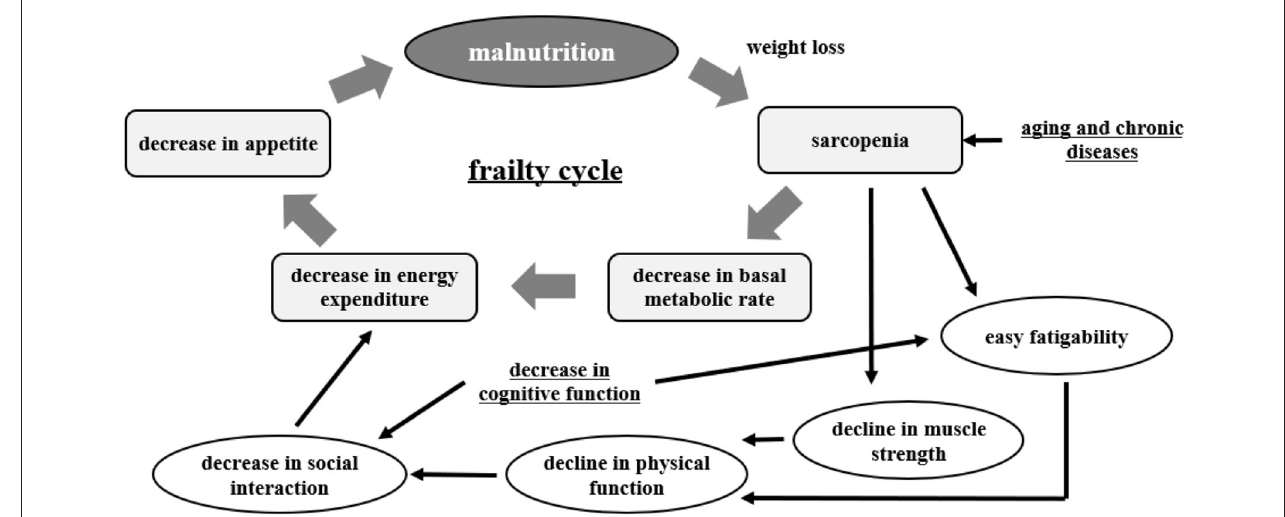
FIGURE 2 | Frailty cycle [modified from Xue